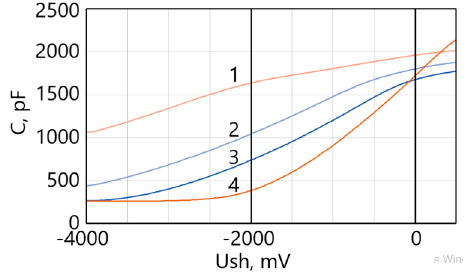
Figure 4. The capacitance-voltage characteristics for capacity sensor at temperatures: 1—170 ° С , 2—140 ° С , 3—100 ° С , 4—pure Pd gate at 100 ° С